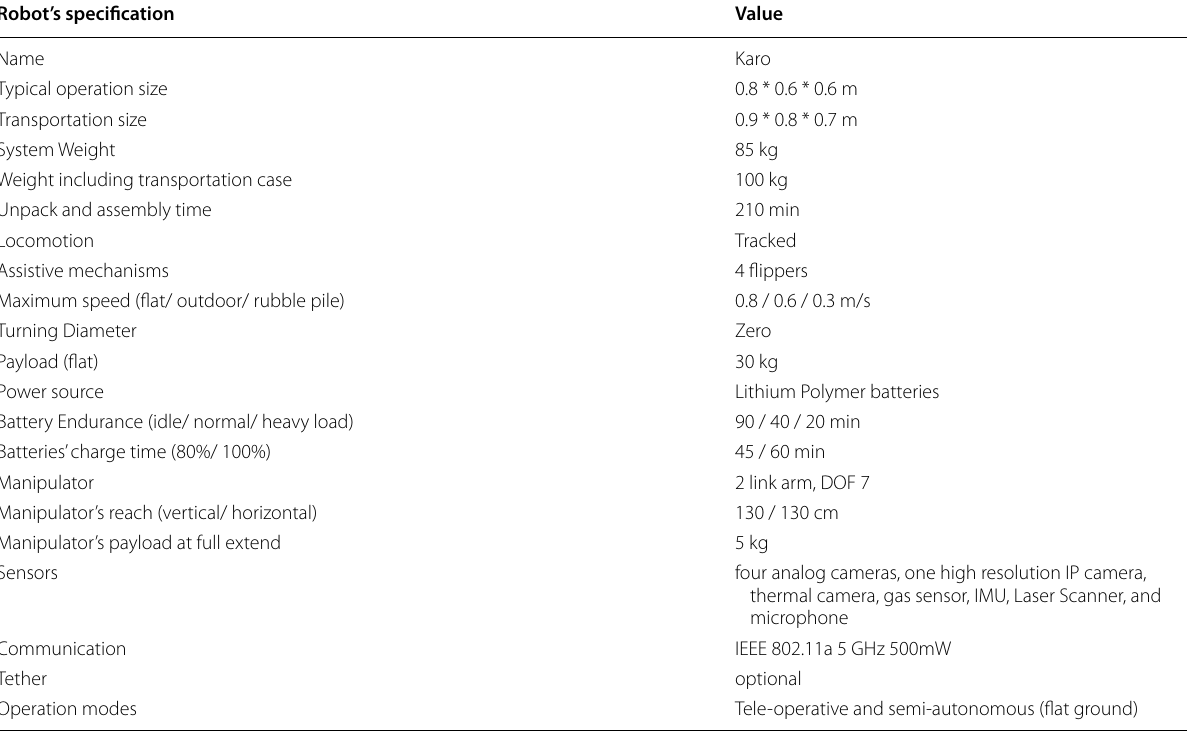
Table 3 Karo’s Specifications Robot’s